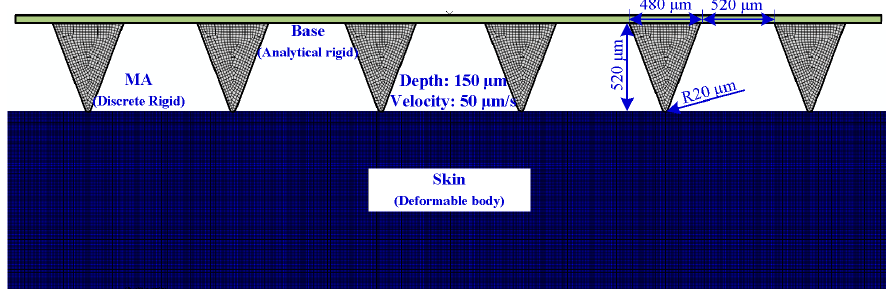
Figure 4. Finite element model of the MAE insertion and pull process.